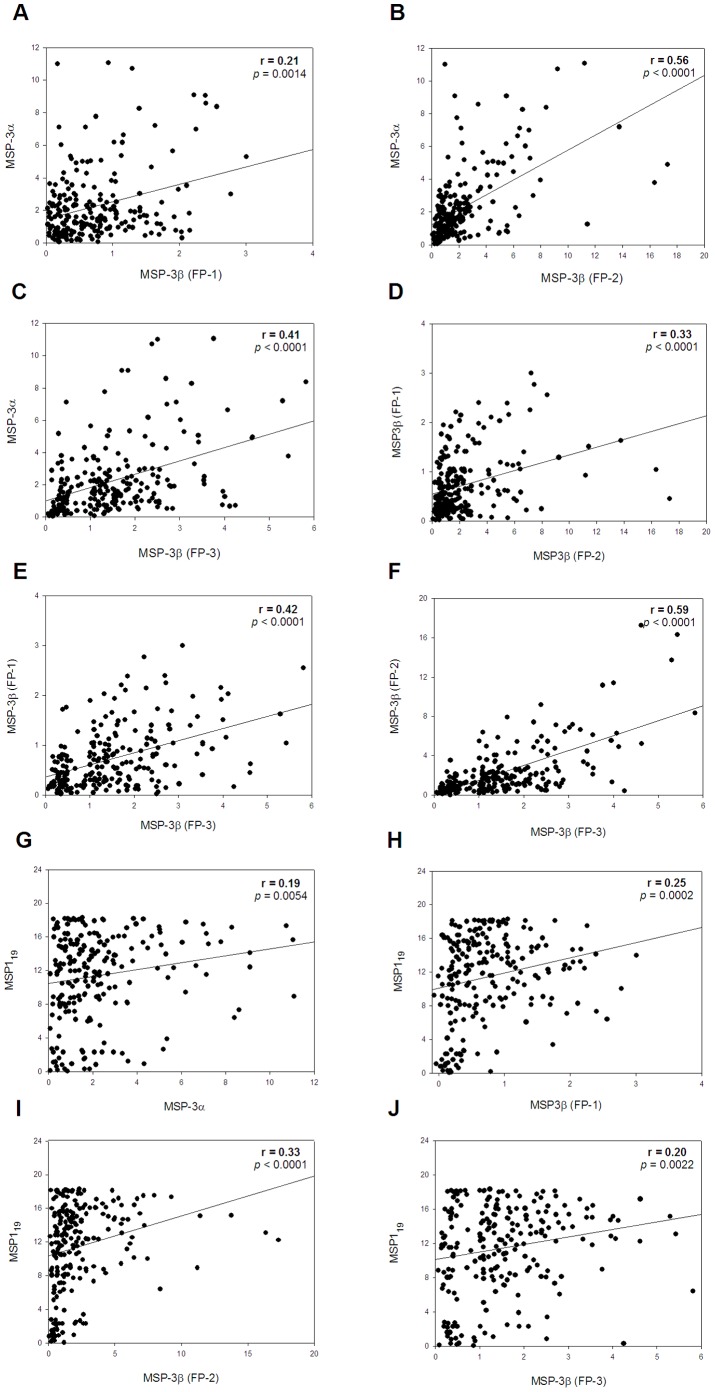
Reactivity against recombinant PvMSP-3 and PvMSP119 proteins in 220 sera from individuals with patent P. vivax malaria infection.Each panel represents the reactivity index of serum samples against the indicated recombinant proteins. The serum samples were tested at a 1∶100 dilution, as described in Figure 1B. Symbols represent the IR IgG antibodies against recombinant MSP proteins in the sera of P. vivax-infected individuals. The values of the Spearman correlation coefficient (r) and p values are shown in each panel.